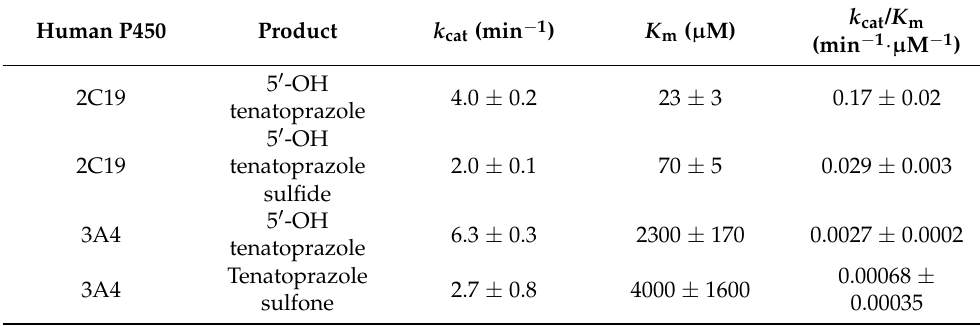
Table 2. Kinetic parameters of tenatoprazole oxidation reactions by human P450s. Human